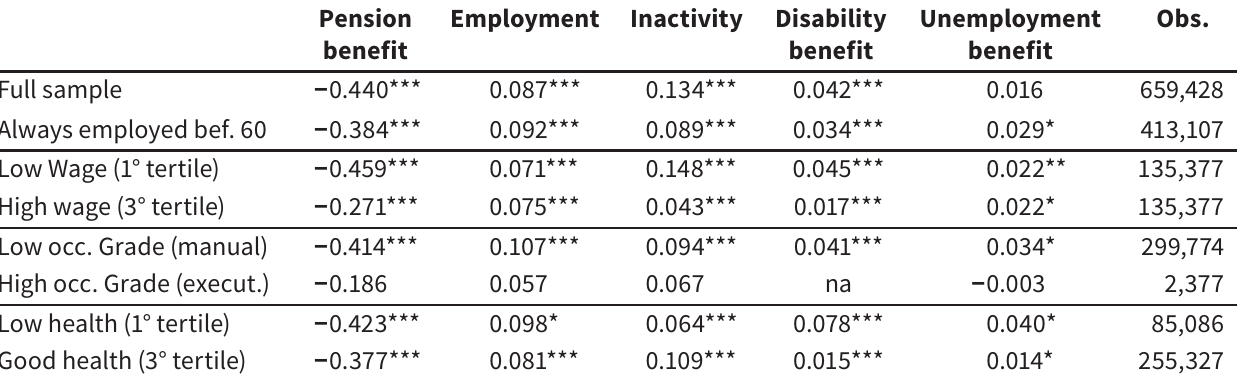
Unemployment Obs. benefit benefit